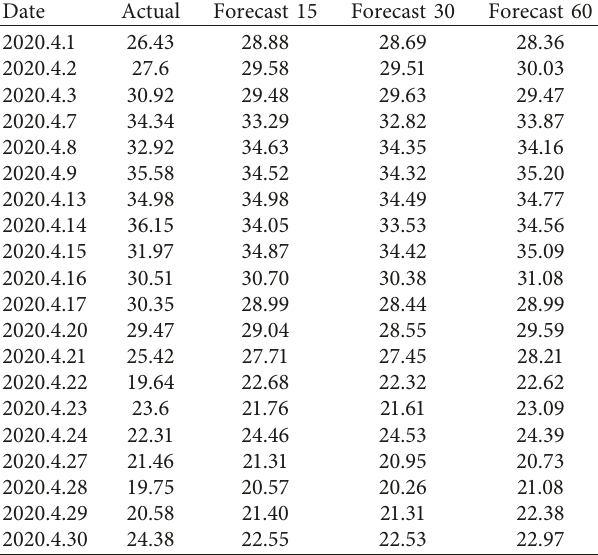
Table 3: Actual and forecast price (USD per barrel) in